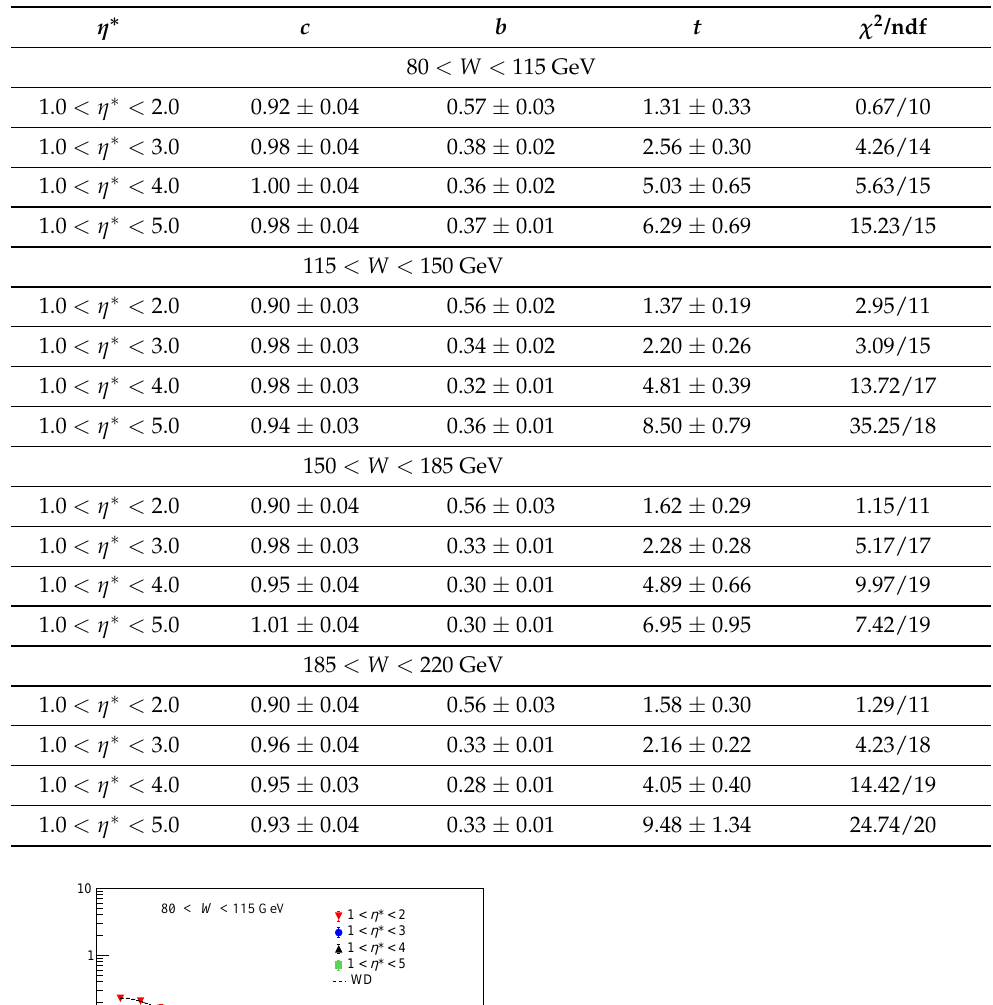
Table 1. Shifted Gompertz distribution, Equation (10), fit parameters b , t , the normalisation constant c , and χ 2 /ndf (number of degrees of freedom) for the multiplicity distributions for n > 0 in different W ranges of the H1 data [33].